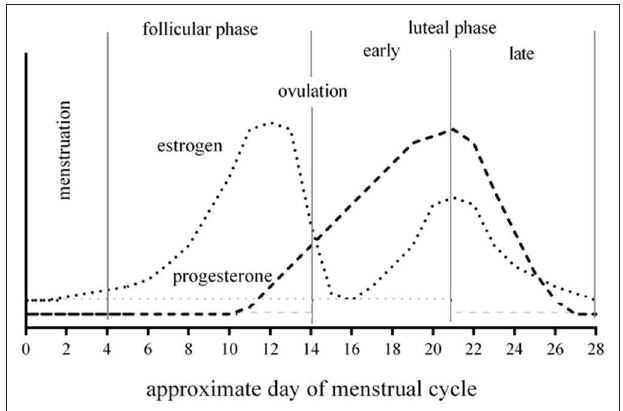
FIGURE 1 | Example 28-day menstrual cycle with changes of ovarian hormones during respective